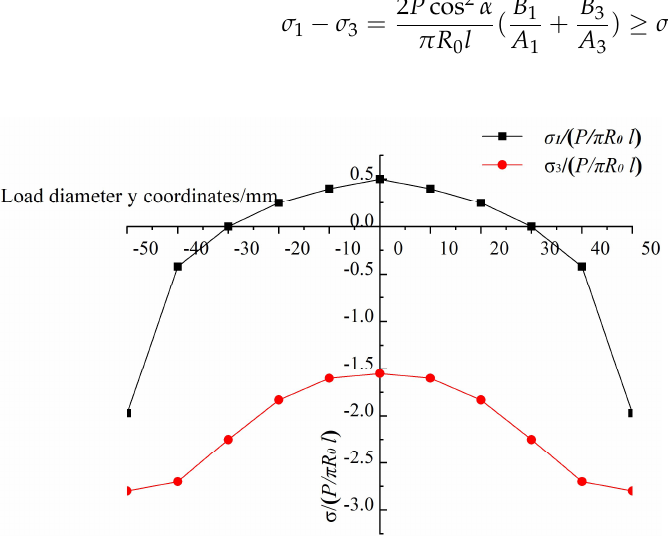
 and  along the loaded diameters. Figure 8. Dimensionless σ 1 3 1 and σ 3 along the loaded